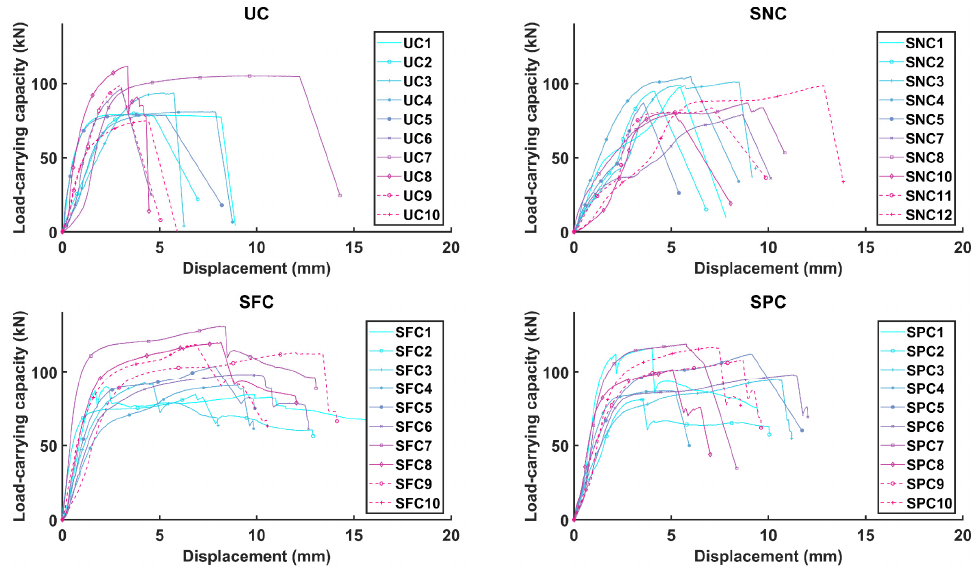
Figure 10. Load-displacement curves for each group in this study.